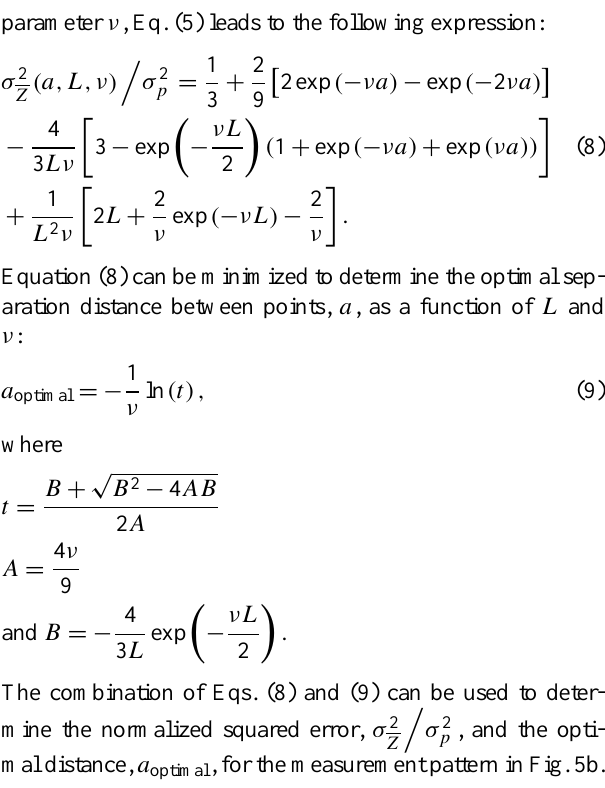
Figure 6. Comparison of the theoretical and sampled normalized squared error ( σ 2 profile section of length L , as in Fig. 5a. The survey case applied to profiles in FS and RW along the x and y directions. Solid lines are the theoretical error using exponential decay exponents derived from the functions fitted to the sampled correlation functions of the two surfaces in the x and y